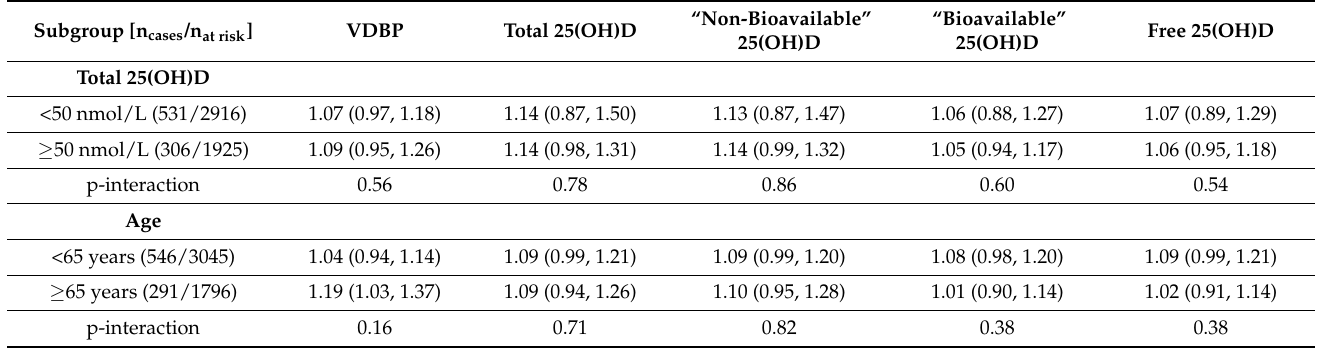
Table 3. Adjusted hazard ratios * of developing diabetes by per standard-deviation decrease in total, “non-bioavailable”, “bioavailable”, and free 25(OH)D concentrations by population